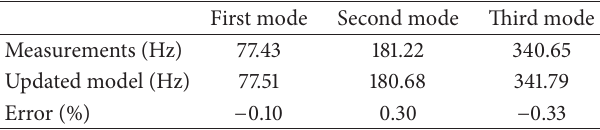
Table 6: Comparison of natural frequencies from measurements and updated model for multiple damage